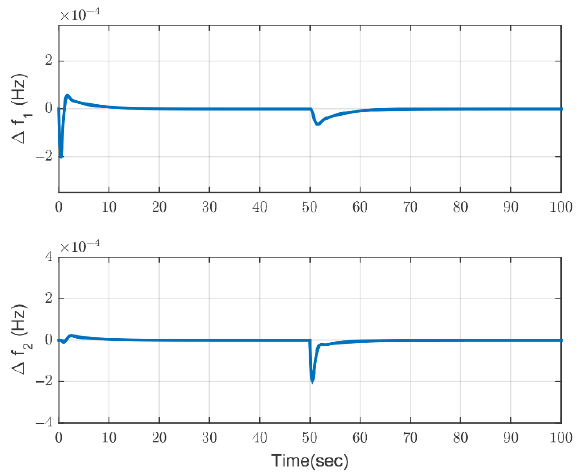
Figure 5. Frequency deviations in the proposed LFC scheme during unit step load disturbance.